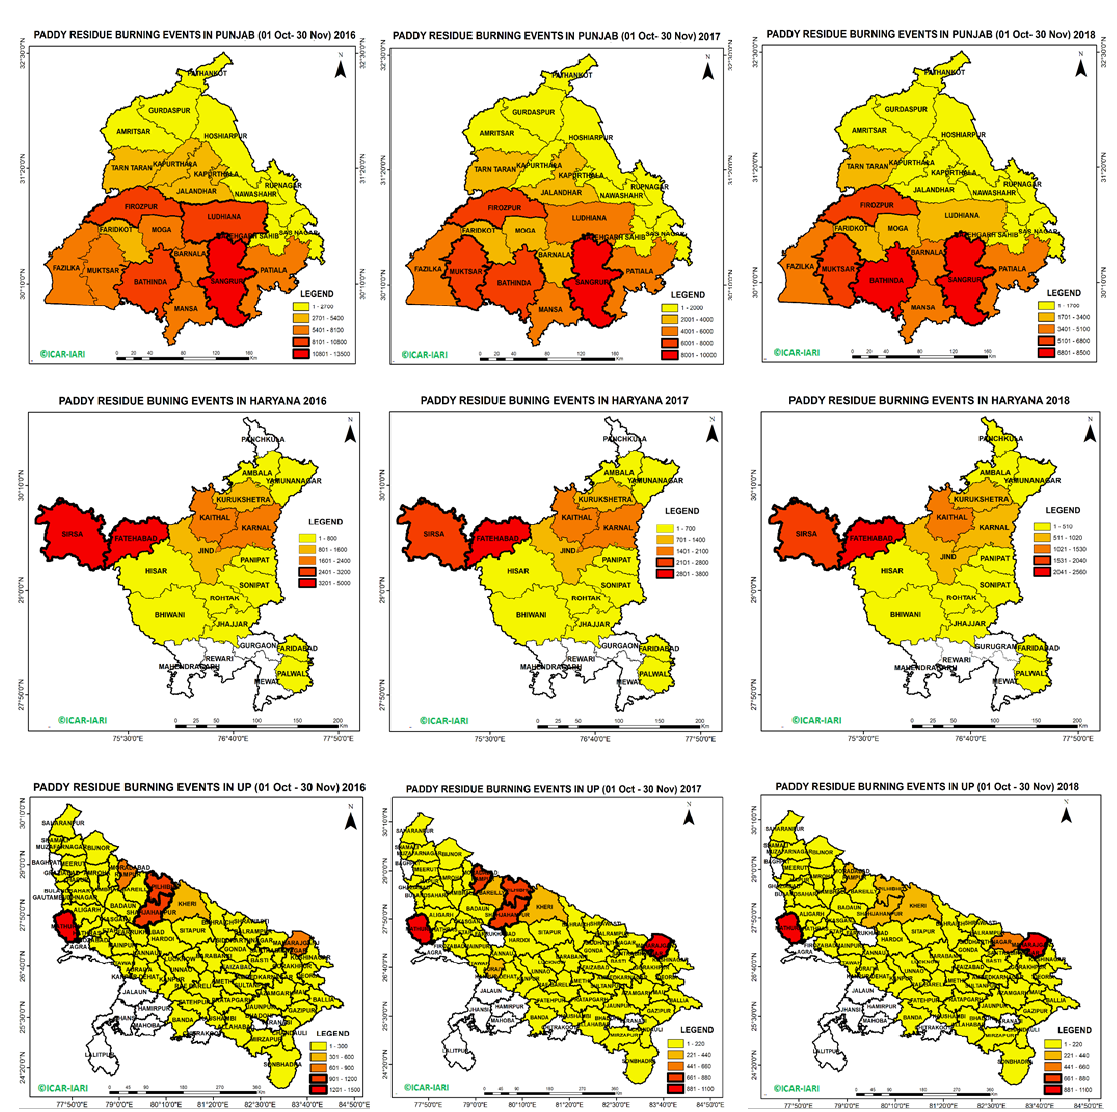
Figure 8. Map depicting the district-wise fire count in Punjab, Haryana and Uttar Pradesh for 2016, 2017 and